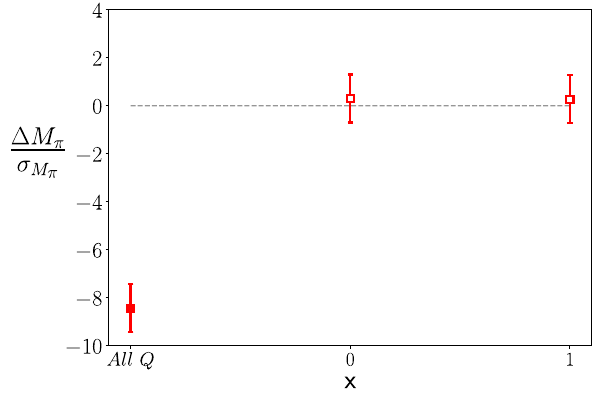
Fig. 16 (cid:12) M π ≡ (cid:7) M π (cid:8) HMC x − (cid:7) M π (cid:8) wHMC x , averaged over all sectors, x = All Q (full symbol), or sectors of fixed x = | Q | (open symbols) as in Eq. (32), versus Q at β = 9 .